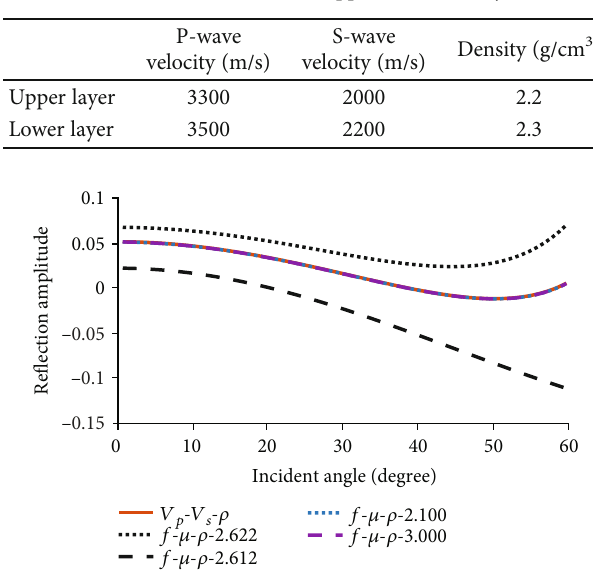
Figure 3: Re fl ection amplitude analysis with incident angle of di ff erent AVO approximations. V P ‐ V S ‐ ρ indicates the Aki- Richards AVO approximation as equation (A.1) shows; λ ‐ μ ‐ ρ indicates the AVO approximation as equation (A.4) shows; K ‐ μ ‐ ρ indicates the AVO approximation as equation (A.5) shows; f ‐ μ ‐ ρ indicates the Russell et al. AVO approximation as equation (A.6) shows. Table 2: Parameters of the upper and lower layers.